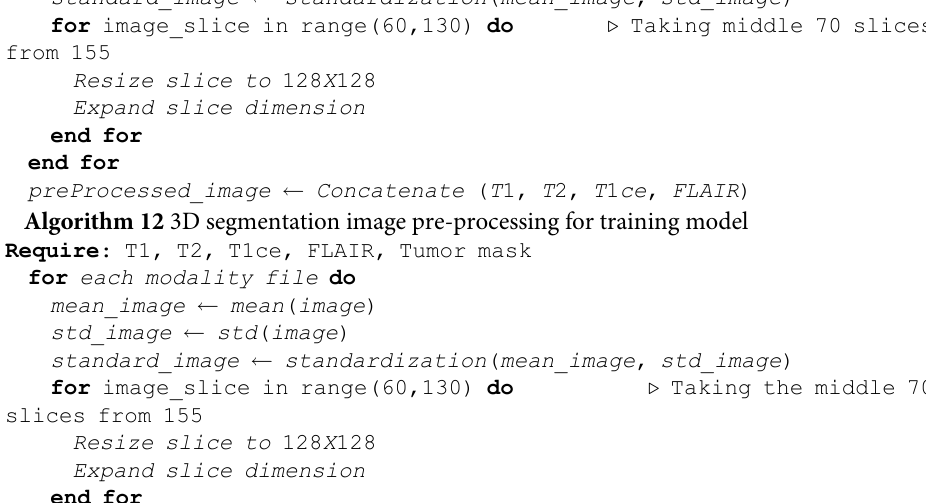
Algorithm 13 Model for 3D brain tumor